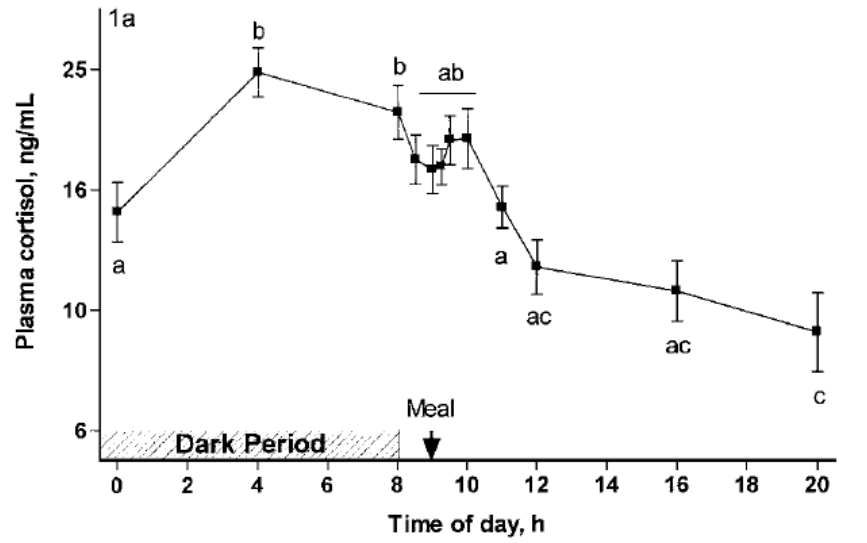
Figure 1. Diurnal changes in plasma cortisol of gestating sows fitted with an indwelling jugular catheter. The meal-induced release of cortisol is clearly visible